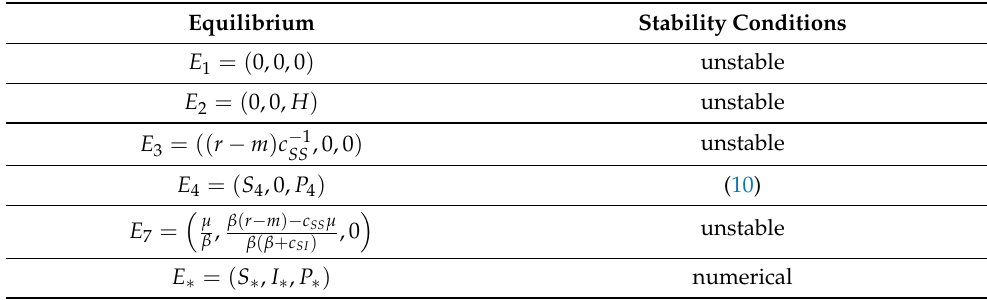
Table 3. Equilibria E k = ( S k , I k , P k ) of (1) and their stability